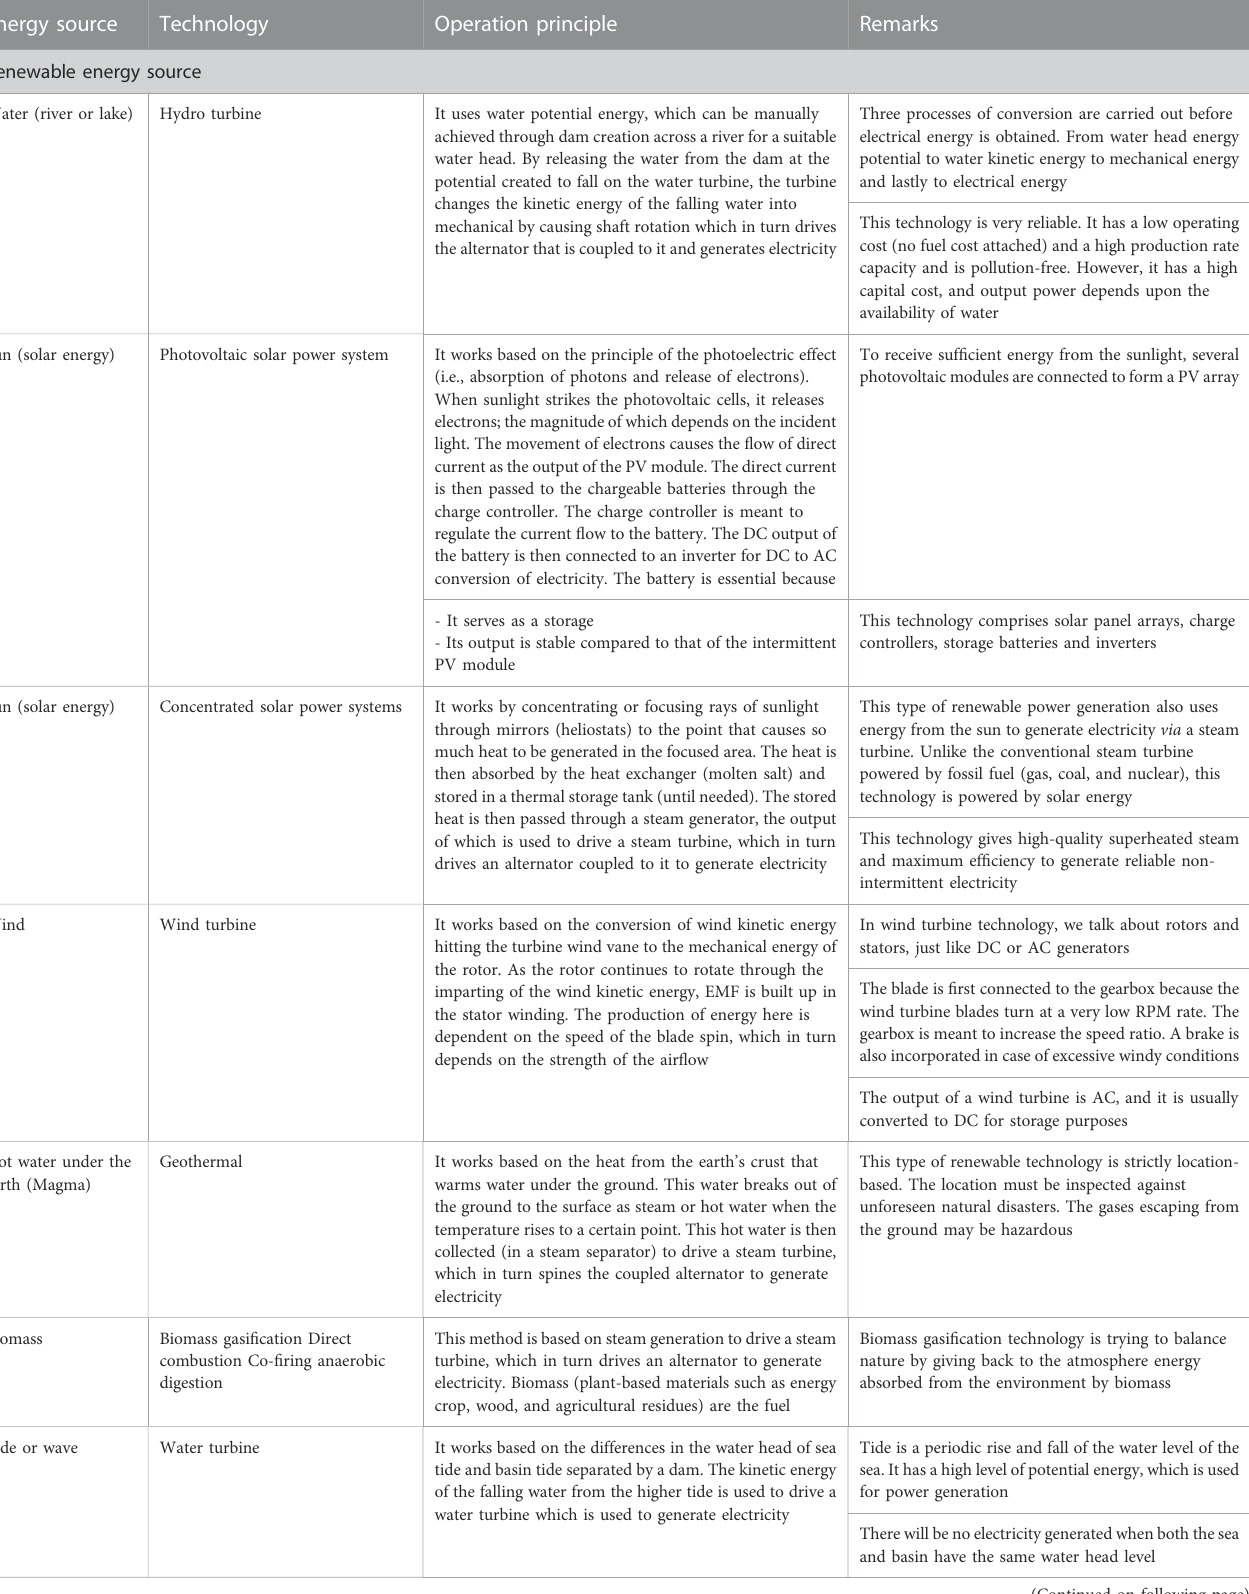
TABLE 1 Renewable energy sources for SSA